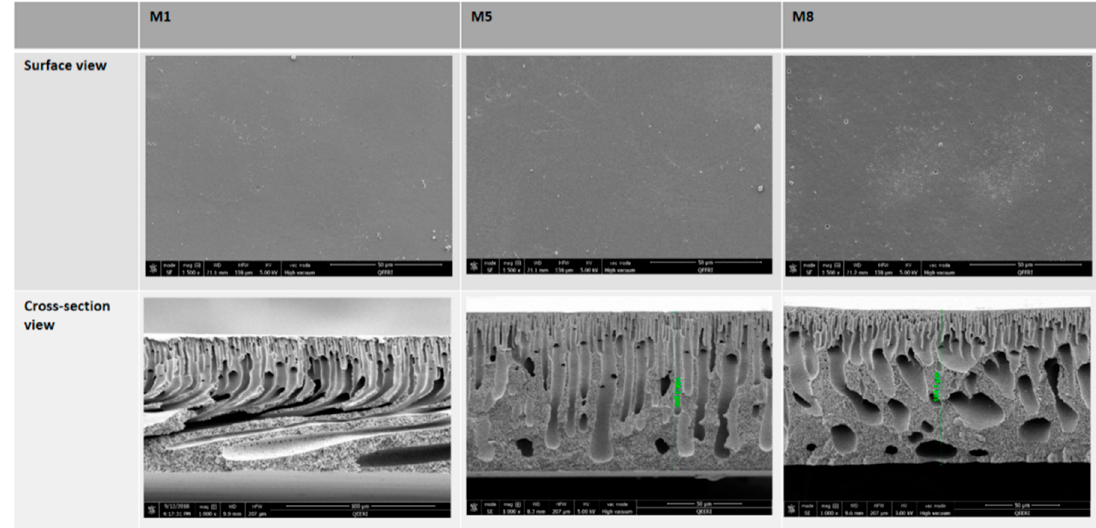
Figure 4. FESEM images of the membrane surfaces and cross-section view of fractured membranes M1, M5 and M8.